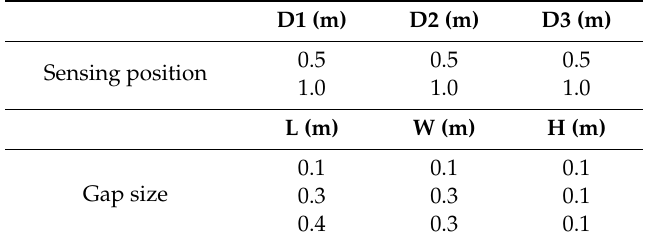
Figure 13. Detailed description of sensor location with impact loading. Table 4. Detailed definitions of gap sizes and sensing positions. Table 4. Detailed definitions of gap sizes and sensing positions.